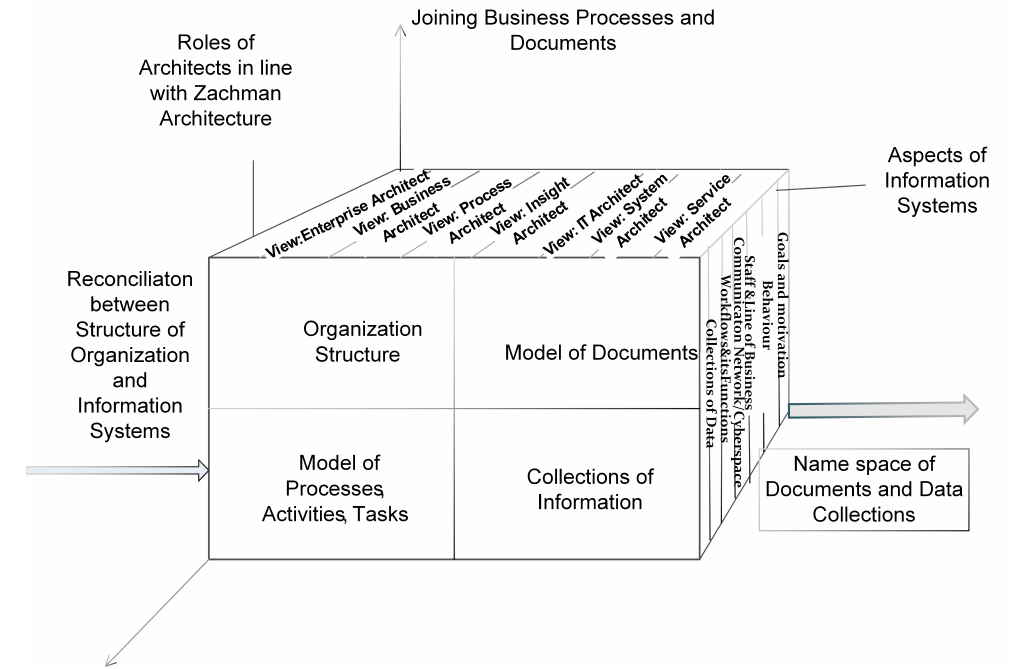
Figure 2. Information System Architecture based on Zachman’s and Blokdijk’s approaches